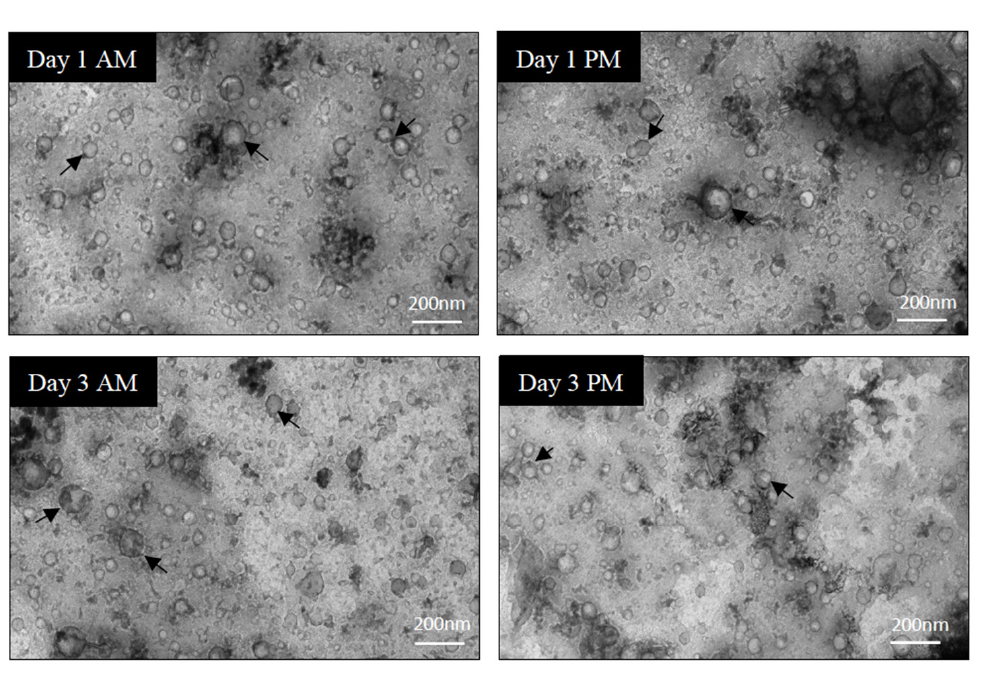
Figure 2. Sample quality assessment and characterisation of EVs using transmission electron mi- croscopy (TEM). Direct mag: 30,000×, no sharpening, normal contrast. Scale bar = 200